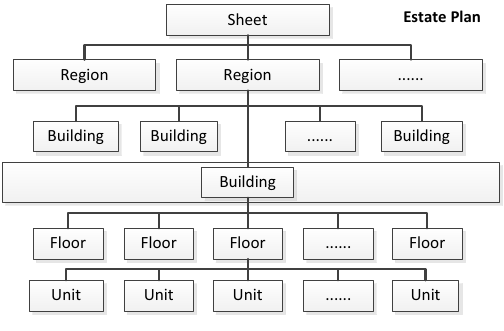
Figure 1 Framework of estate spatial data